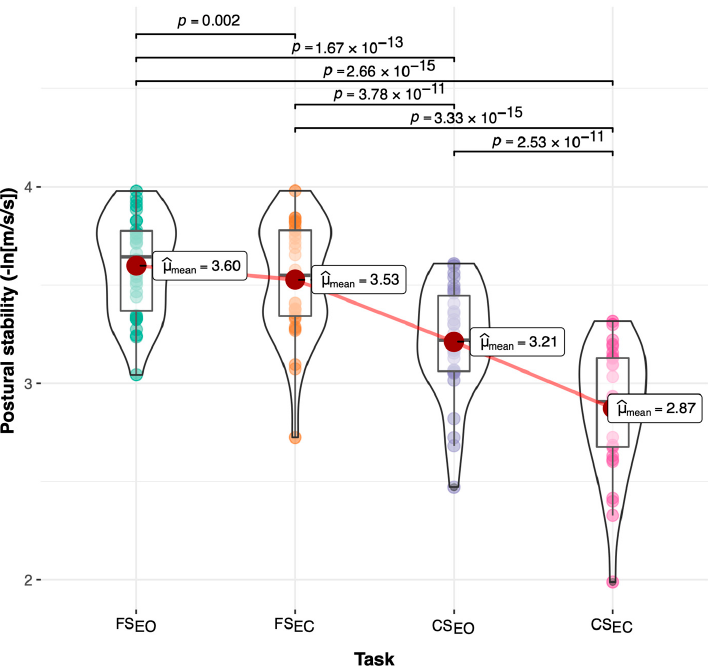
Figure 4. Pairwise comparisons for postural stability across static tasks. FS EO = static balance task on a firm surface with eyes opened; FS EC = static balance task on a firm surface with eyes closed (decreased visual feedback); CS EO = static balance task on compliant surface with eyes opened (altered proprioceptive feedback); CS EC = static balance task on compliant surface with eyes closed (decreased visual and proprioceptive feedback).